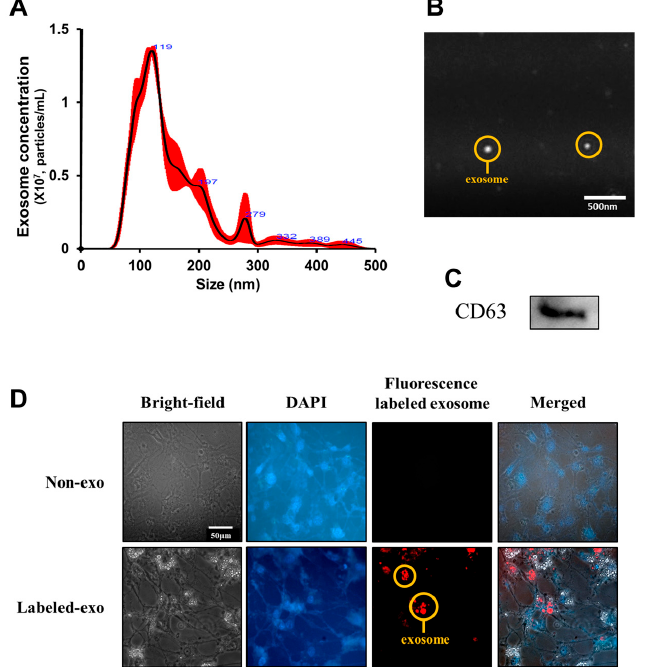
Figure 4. Identification and quantification of secreted liver-derived exosomes. Size distribution ( A ), images for isolated liver-derived exosomes (Scale bar = 500 nm) ( B ), expression of the exosome marker CD63 ( C ). Red fluorescence-labeled liver-derived exosome uptake in 3T3-L1 cells. Representative fluorescence microscope images show the distribution of liver-derived exosomes, as indicated by the PKH-26 red fluorescent dye, whereas cell nuclei were stained with DAPI (blue) (Scale bar = 50 μ m) ( D ).